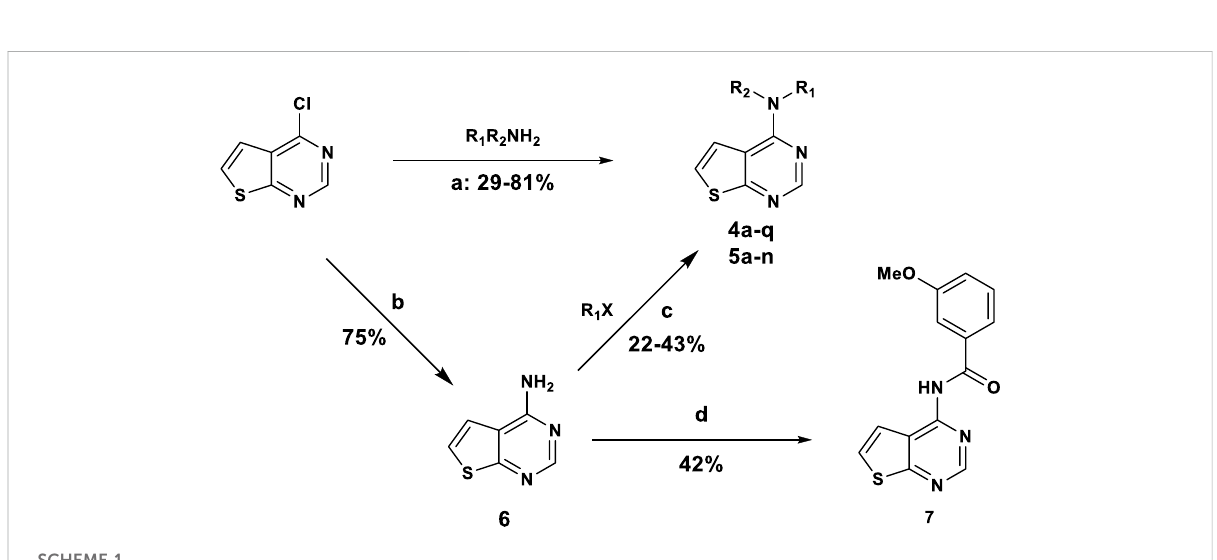
SCHEME 1 General synthesis of Thieno [2,3-d]pyrimidine derivatives: (A) DIPEA, DMF, 100 ° C, 4 h; (B) NH 4 OH, 90 ° C 12 h; (C) NaH 60%, THF, 0 ° C to rt, 12 h; (D) 3-methoxybenzenesulfonyl chloride, Et 3 N, DCM, rt, 24